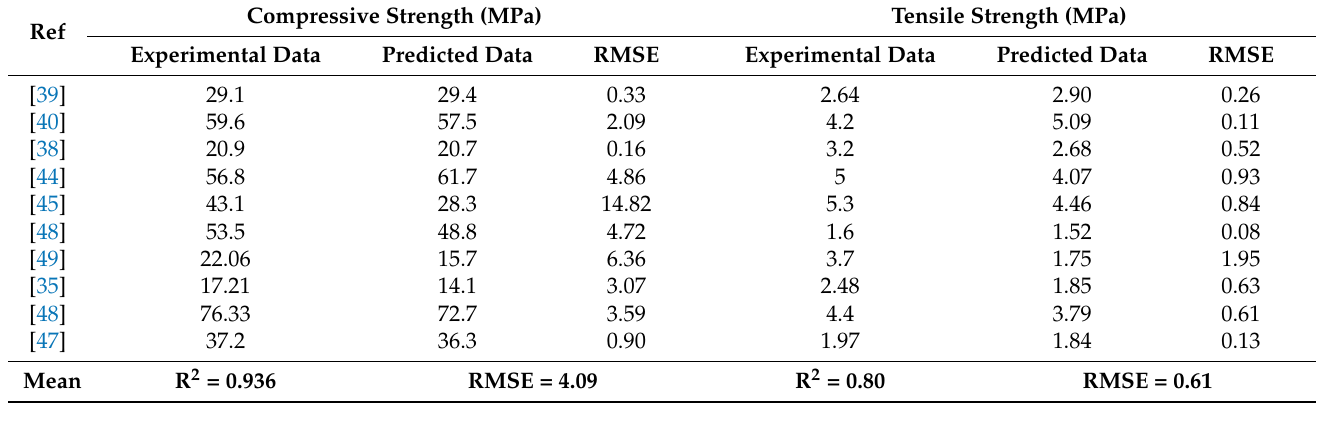
Table 5. ANN-II model testing with regression analysis.